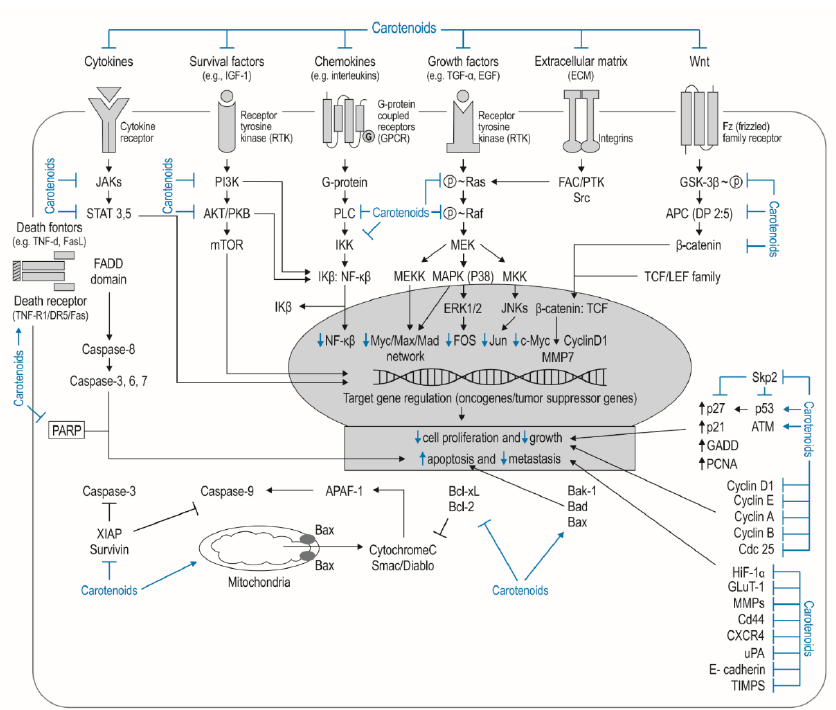
Figure 3. Some potential biological intracellular targets of carotenoids in head and neck cancer (HNC). JAK: Janus kinases, STAT: signal transducer and activator of transcription proteins, FADD: FAS-associating death domain-containing protein, PARP: poly (ADP-ribose) polymerase, XIAP: the X-linked inhibitor of apoptosis protein, NF-κB: nuclear factor kappa-light-chain-enhancer of activated B cells, IκB: IkappaB kinase or IKK, PLC: phospholipase C, APAF-1: apoptotic protease acti- vating factor 1, Smac/Diablo: second mitochondria-derived activator of caspases, PI3K: phospho- inositide 3-kinases (or phosphatidylinositol 3-kinase), AKT/PKB: protein kinase B, mTOR: the mam- malian target of rapamycin, MAPK/MKK/MEKK: mitogen-activated protein kinase kinases, EGF: epidermal growth factor, Ras/Raf: RAF proto-oncogene serine/threonine-protein kinases, JKN: c- Jun N-terminal kinase, MMP: matrix metallopeptidase or matrixin, Src: proto-oncogene tyrosine- protein kinase Src, GSK3β: glycogen synthase kinase 3 beta, APC (DP 2.5): polyposis coli (APC) or deleted in polyposis 2.5, TCF/LEF: T cell factor/lymphoid enhancer factor family, Bcl-xL: B-cell lym- phoma-extra-large, Bcl-2: B-cell lymphoma 2, Bak-1: Bcl-2 homologous antagonist killer, Bad: the Bcl-2-associated agonist of cell death, Bax: apoptosis regulator or Bcl-2-like protein 4, Skp-2: S-phase kinase-associated protein 2, p53: tumour suppressor p53, ATM: ATM serine/threonine kinase check- points, the G1/S and the G2/M, during the cell cycle, GADD: growth arrest and DNA-damage-in- ducible protein GADD45 gamma, PCNA: proliferating cell nuclear antigen, p27 Kip1 : cyclin-depend- ent kinase inhibitor 1B, p21 Cip1/Waf1 : cyclin-dependent kinase inhibitor 1 or CDK-interacting protein 1, HIF-1α: hypoxia-inducible factors alpha, GLUT-1: glucose transporter 1, CXCR4: C-X-C chemo- kine receptor type 4, uPA: urokinase-type plasminogen activator, TIMPS: tissue inhibitors of metal- loproteinases (TIMPs); ~P: phosphorylated form. 3.3. Animal and In Vitro Models of Head and Neck Squamous Cell Cancer Extensive preclinical research has been performed on the stages of carcinogenesis, and the findings play a key role in understanding the tumorigenesis process in HNC- related organ sites. In the literature from the last twenty years, several key in vivo and in vitro scientific works have studied whether carcinogens and/or carotenoids, and other phytochemicals, modulate the proliferation of CSC stem cells or HNSCC cells [38].